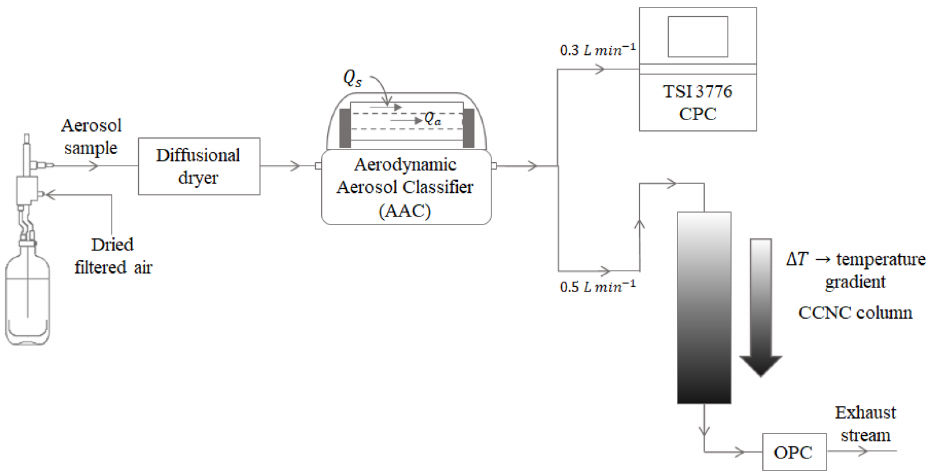
Figure 2. AAC–CCNC experimentation setup for measuring the size-resolved number concentration of